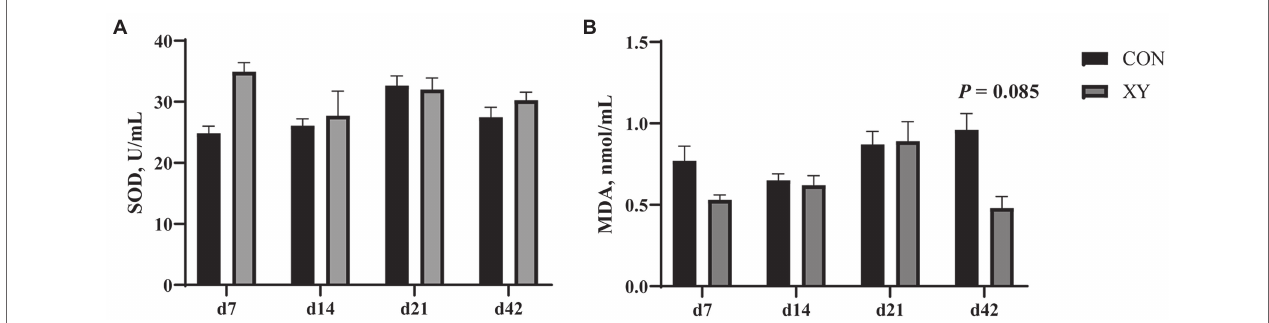
FIGURE 6 | Effects of AT-xynA on antioxidant capacities in the ileum of broilers. (A) SOD, superoxide dismutase; (B) MDA, malondialdehyde concentrations in the ileum of broilers. CON is AT-xynA un-supplemented group; XY is 4,000 U/kg AT-xynA supplemented group.